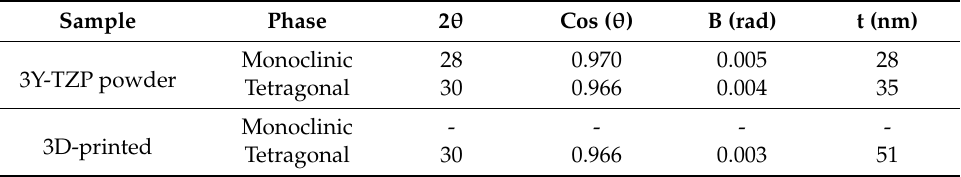
Table 1. Application of the Debey–Scherrer equation 1 for 3Y-TZP powder and 3D-printed zirconia cubes.